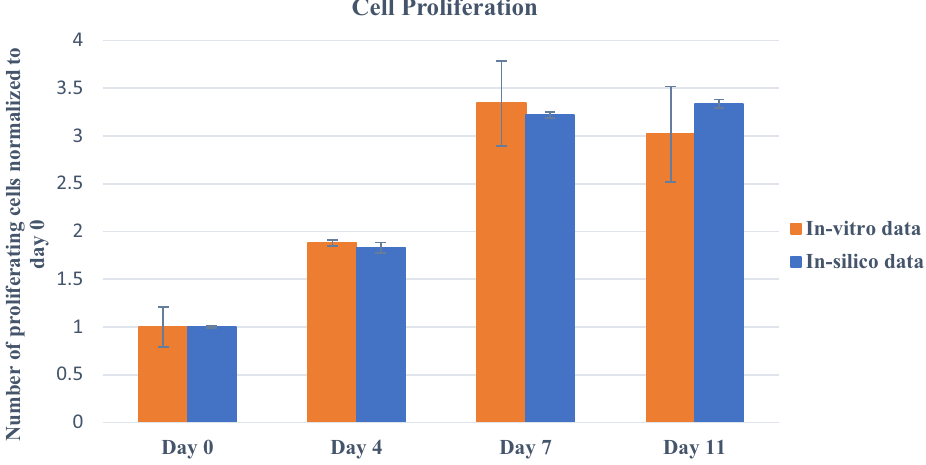
− 1 6 cells mL in 4% gelatin/5%